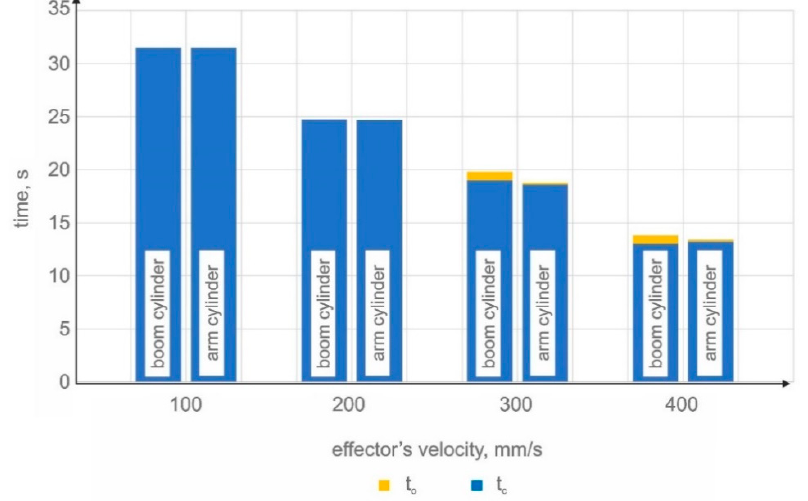
Figure 24. Time t c and t o for different speeds of movement of the effector for the drive system with counterbalance valves.